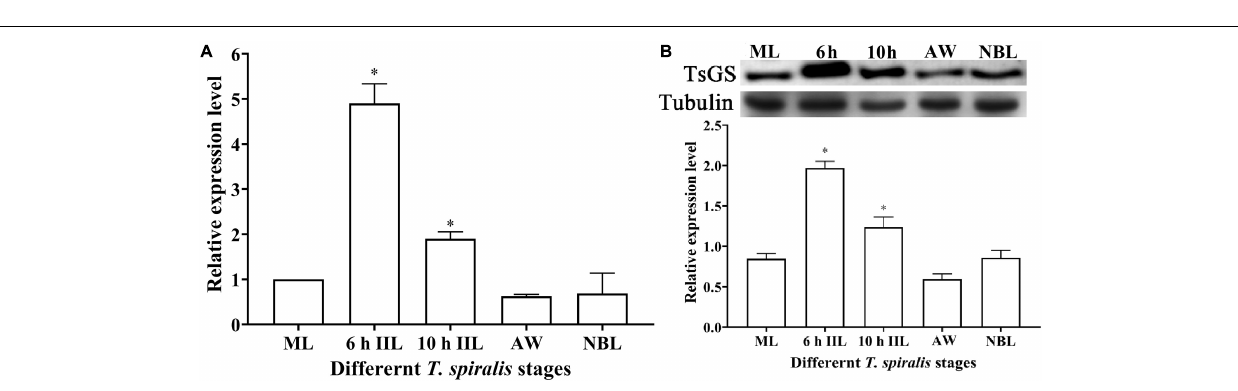
Frontiers in Cell and Developmental Biology |